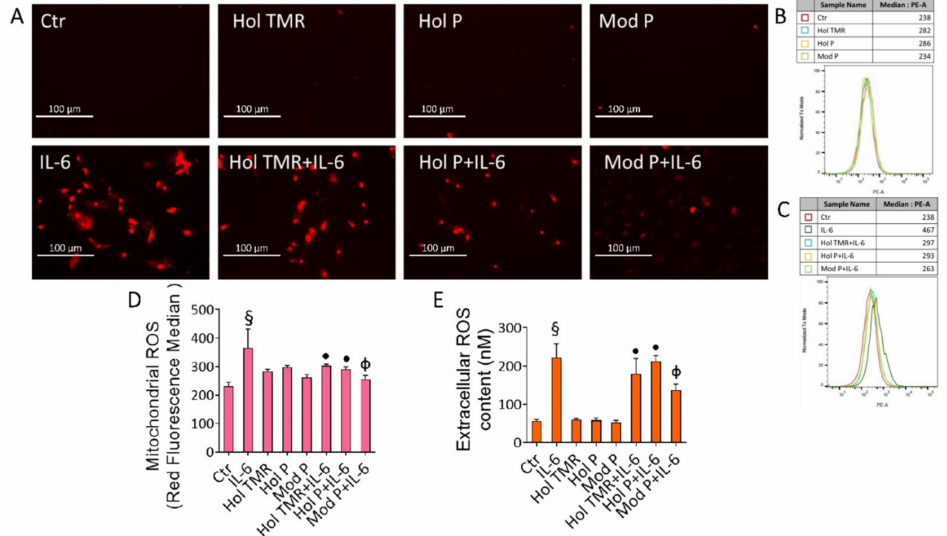
Figure 3. Milk extract effects on oxidative status. ( A ) Representative images by fluorescence mi- croscopy and ( B – D ) FACS analysis, expressed as fluorescence median ± SD of n = 3 independent experiments, of mitochondrial and ( E ) extracellular ROS detection in ECs treated with Hol TMR, Hol P, and Mod P milk (20% v / v ) for 72 h, IL-6 (20 ng/mL) for 24 h, or pretreated for 16 h with milk before stimulation for 24 h with IL-6. Scale bars = 100 µ m. Control cells (Ctr) were treated with the corresponding highest volume of HBSS-10 mM Hepes: § p < 0.001 vs. Ctr; • p < 0.05 vs. IL-6; Φ p < 0.01 vs.